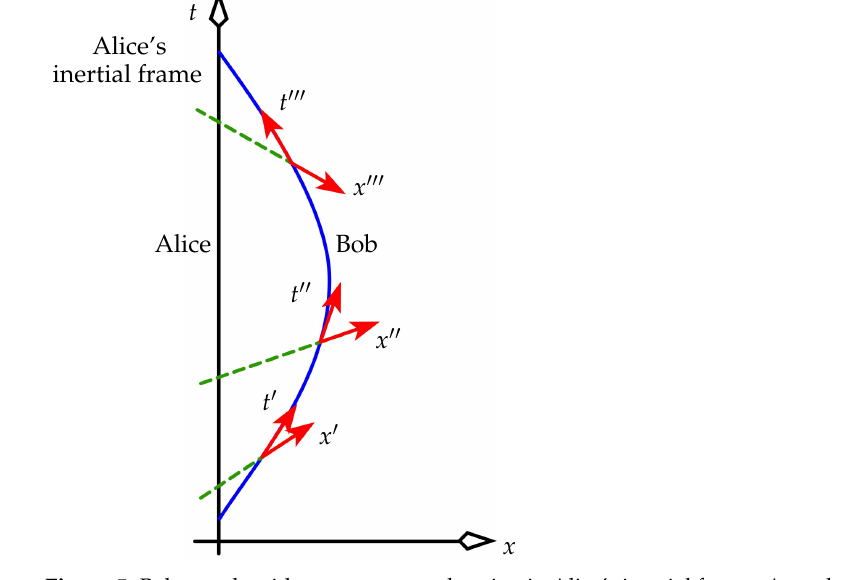
Figure 5. Bob travels with a constant acceleration in Alice’s inertial frame. At each event on his world line, we draw the space and time axes of his MCIF in the same way as in Figure